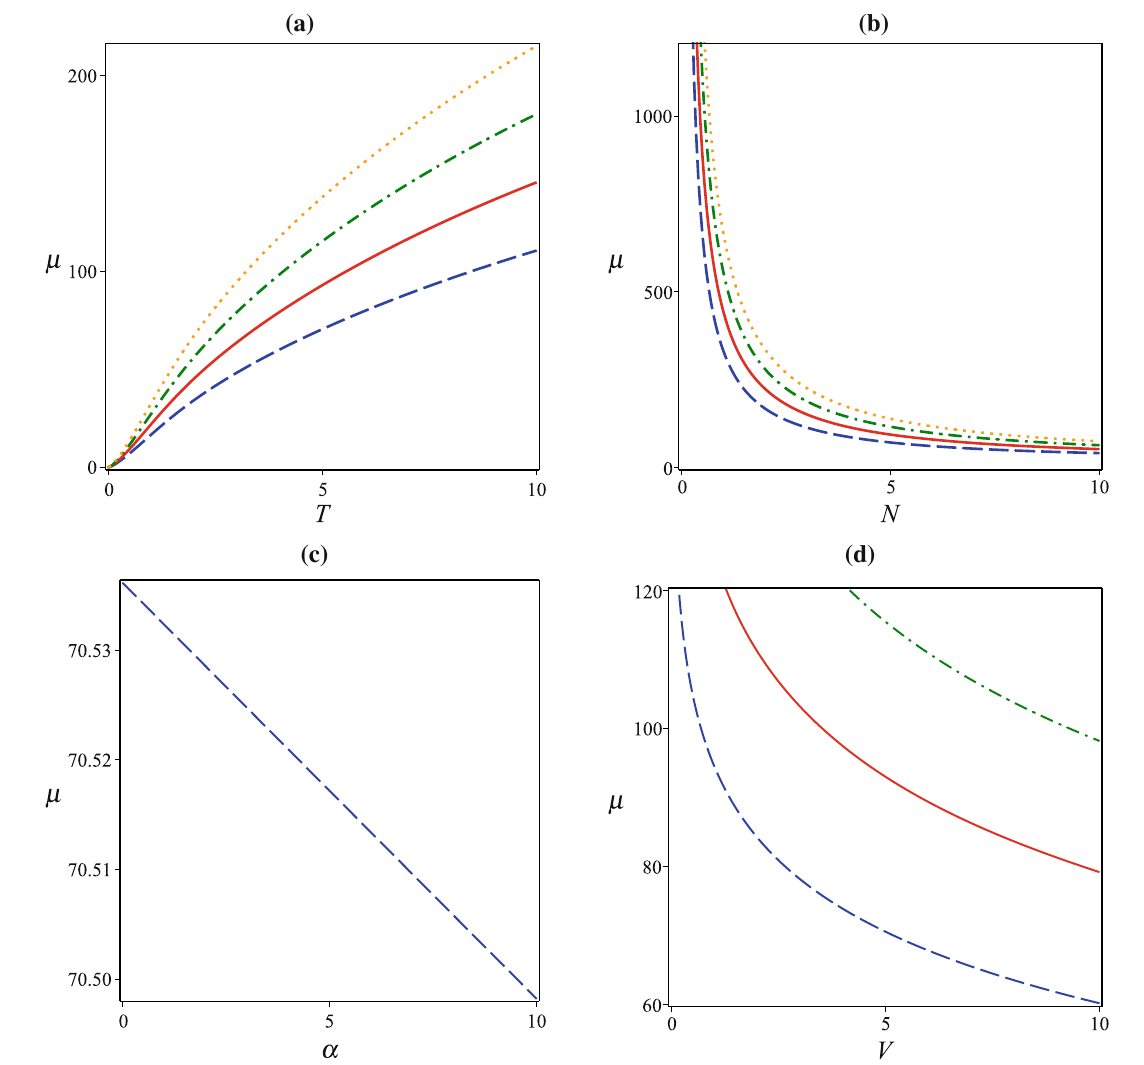
Fig. 5 Typical behavior of the chemical potential in terms of a T , b N , c α and d V . N l = 5; l = 1 , 2 , 3 (blue dash), l = 1 , 2 , 3 , 4 (red solid), l = 1 , 2 , 3 , 4 , 5 (green dash dot); l = 1 , 2 , 3 , 4 , 5 , 6 (orange